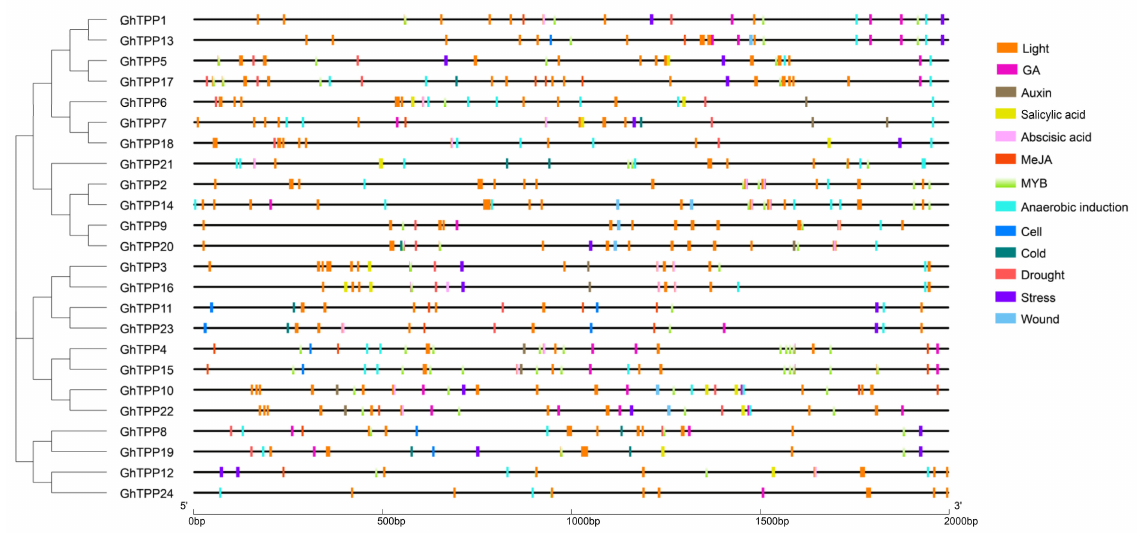
Figure 5. Cis-element analysis of the TPP genes in G. hirsutum . The black line represents the 2000-bp sequence upstream of the CDS, and squares of different colours represent various cis-elements. The evolutionary tree is shown on the left.